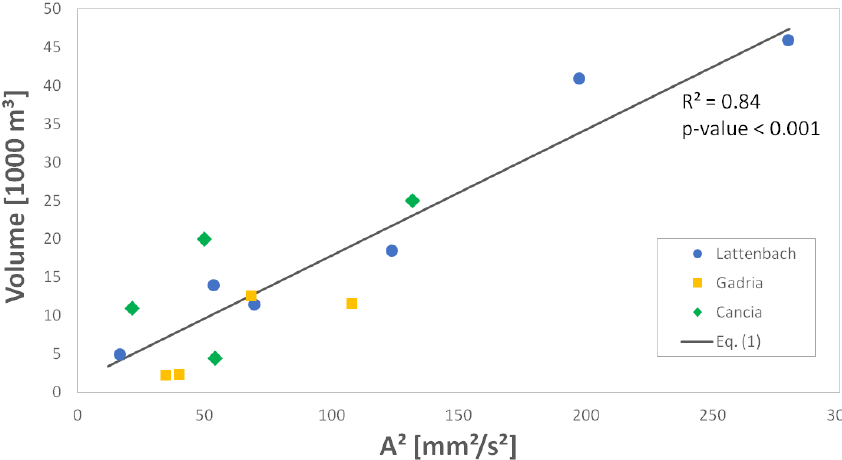
Figure 6. Relationship between squared integrated seismic amplitude and total volume based of the debris flow events listed in Table 2 (from Gadria, Lattenbach, and